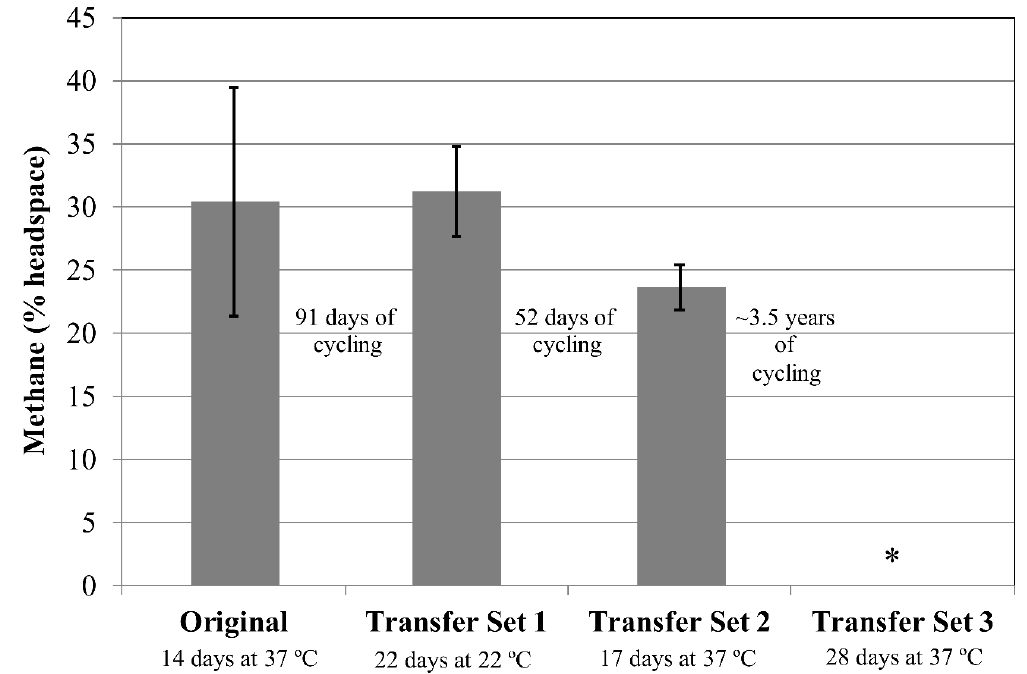
Figure 2. Methane production by Methanobacterium formicicum following an initial incubation period for each of three sets. Test tubes for the Original Set and Transfer Sets 1 and 2 contain 5 g sand and 10 mL MSF medium. Transfer Set 3 tubes contain 10 mL MSF medium only. Transfer Set 1